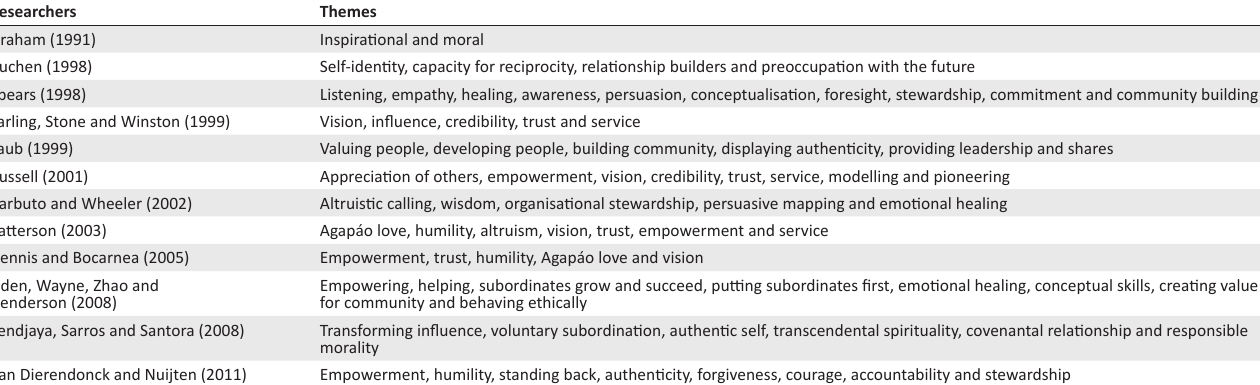
TABLE 2: The dominant themes of servant leadership.